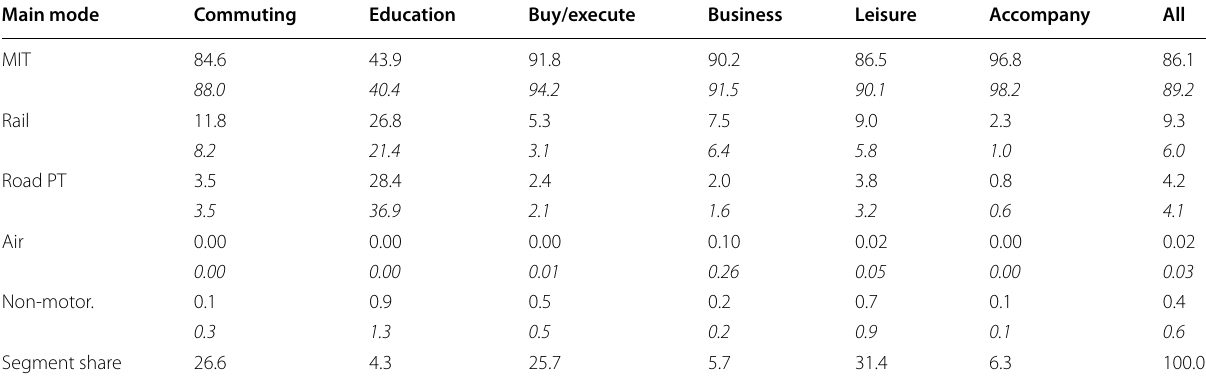
Validation data in italic font The upper value represents quetzal_germany’s results, the lower is the survey average from